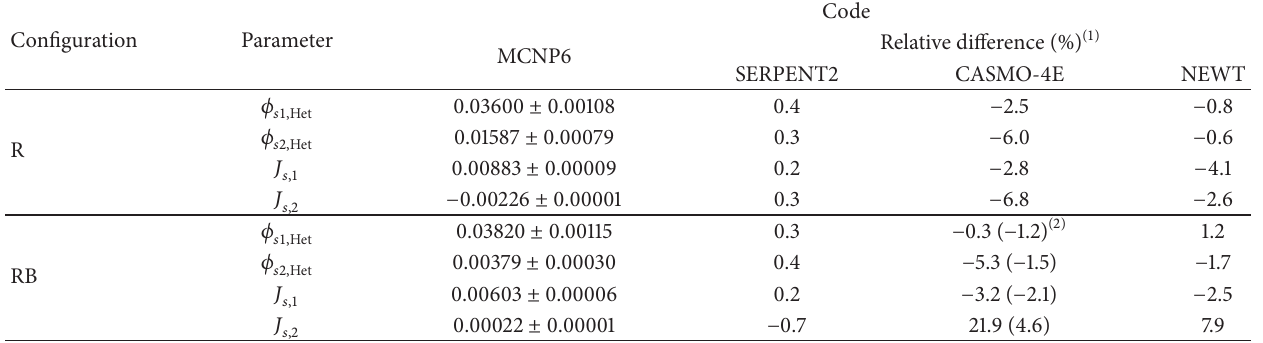
Table 6: Interface current and interface flux between fuel node and reflector node.